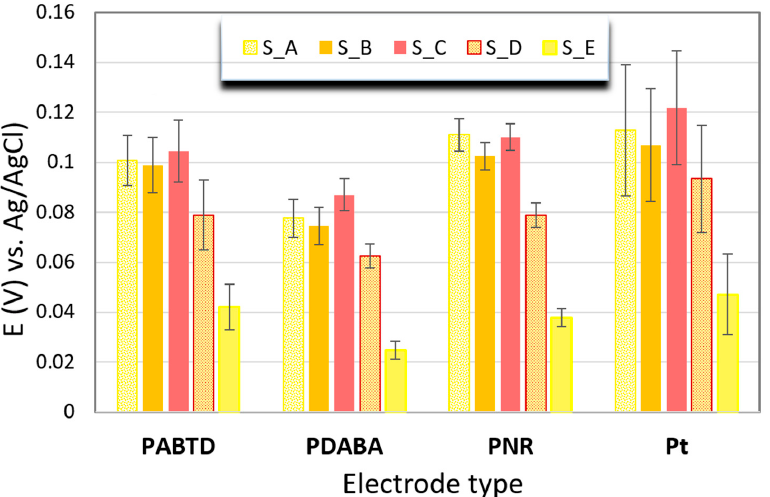
Figure 4. The potential response of the electrode array (12 electrodes) on 5 samples of effervescent tablets (labeled S_A–S_E) dissolved in acetate buffer. The color scale of the columns corresponds to the actual color of the measured tablets. Error bars represent sampling standard deviations for n =